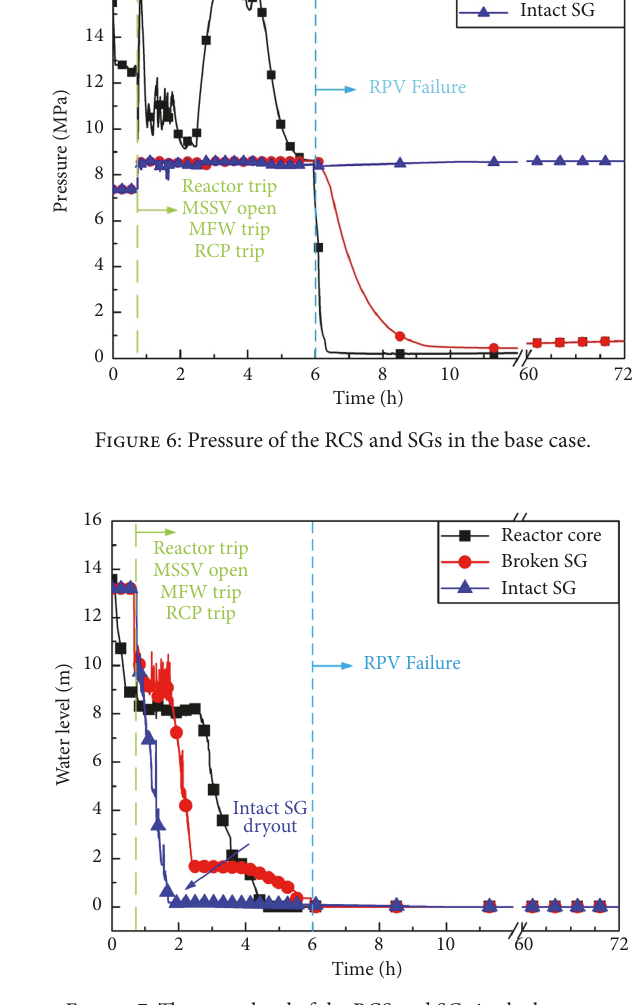
Figure 7: The water level of the RCS and SGs in the base